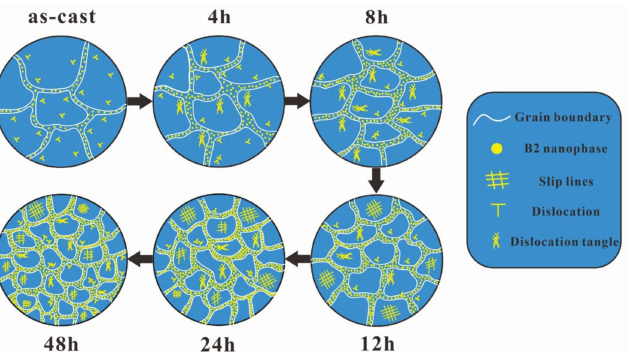
Figure 7. Microstructure evolution and strengthening mechanism of Al 0.6 CrFe 2 Ni 2 HEA caused by cryogenic